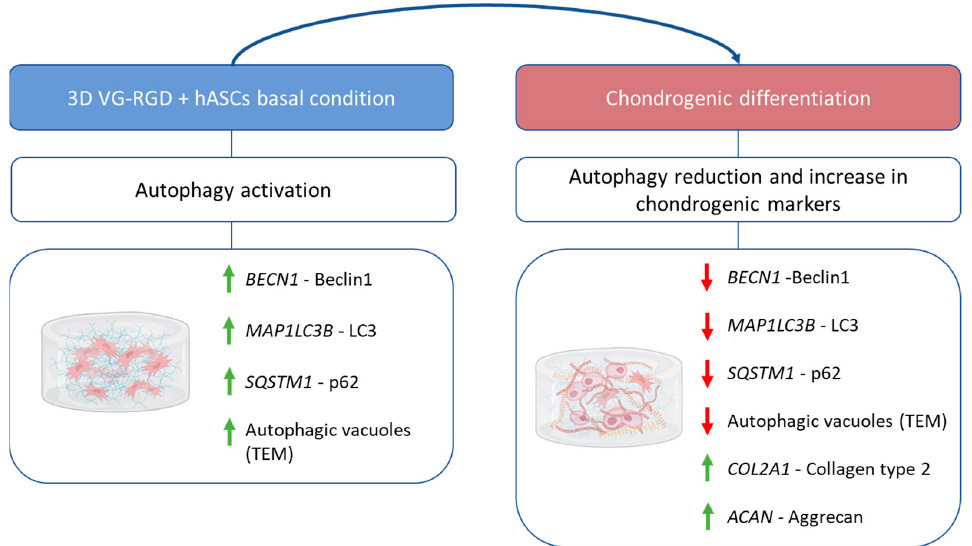
Figure 10. Summary of the main results of autophagy in chondrogenic differentiation of hASCs laden in VG-RGD hydrogel. Green arrows indicate induced markers, red arrows indicate reduced markers.